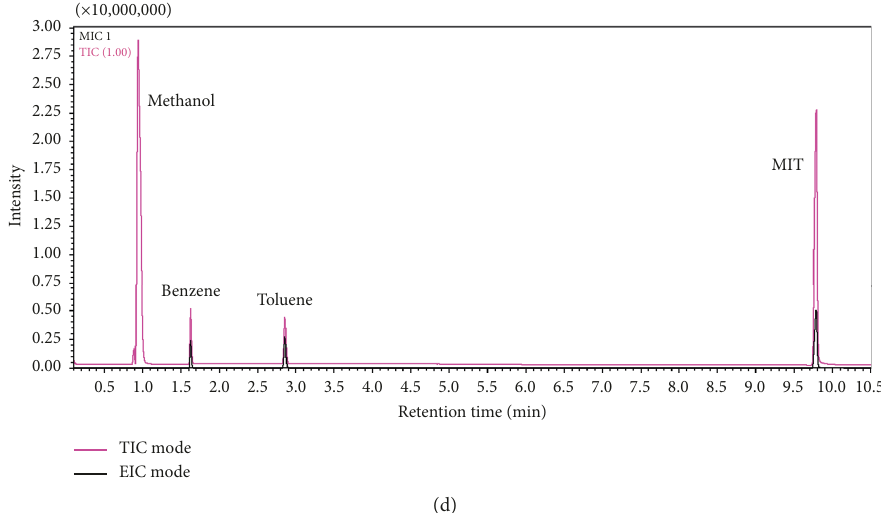
Figure 2: Chromatograms of the three target compounds based on four different solvents. The concentrations varied 208ng · μ L − 1 (benzene),